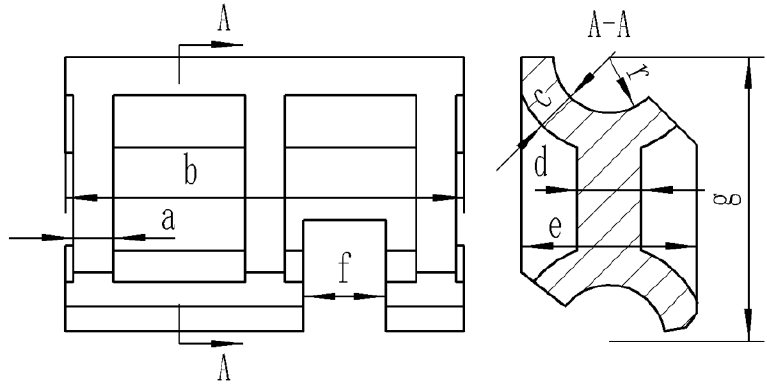
Figure 13. Structural parameters of lightweight drive rod. Table 1. Design parameters range of the lightweight drive rod.